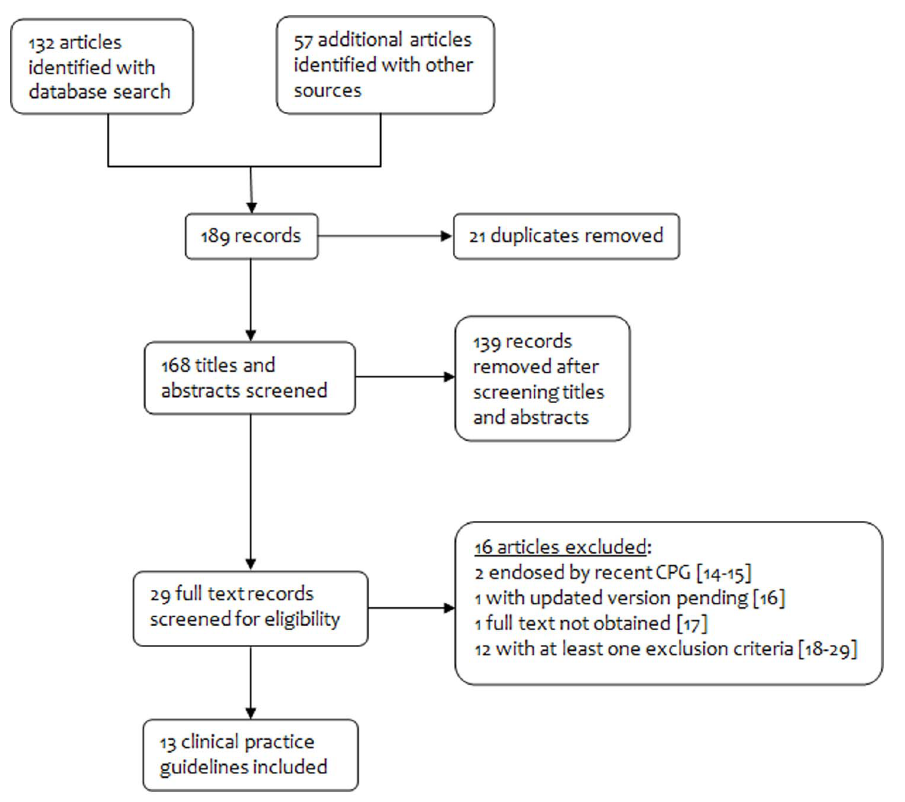
Figure 1. Search